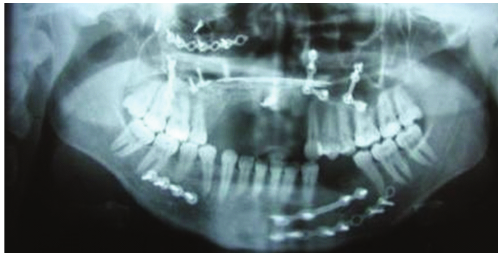
Figure 2: Panoramic radiograph showing mini plates and screws used for fixing fractured zygomatic arch, orbital, and maxillary sinus walls.